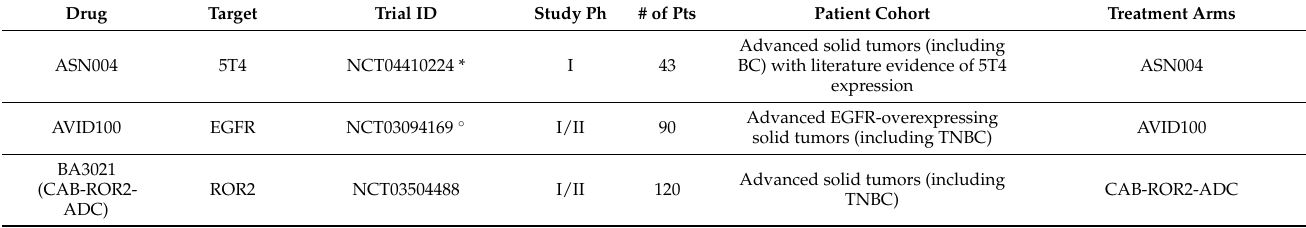
Table 2. Summary of the current clinical trials investigating antibody drug conjugates with targets other than HER2. Legend: ◦ Active, not recruiting; * Not yet recruiting. Abbreviations: ID, identifier; pts, patients; BC, breast cancer; EGFR, epidermal growth factor receptor; mTNBC, metastatic triple negative breast cancer; mBC, metastatic breast cancer; HER2, human epidermal growth factor receptor 2; CT, chemotherapy; ET, endocrine therapy; HR, hormone receptor; TPC, treatment of physician’s choice; eBC, early breast cancer; FRA, folate receptor alpha; HER3, human epidermal growth factor receptor-3; PD-L1, programmed death-ligand 1; 5T4, oncofetal antigen 5T4; ROR2, receptor tyrosine kinase-like orphan receptor 2; TROP-2, Trophoblast cell surface antigen 2; LIV-1, Zinc transporter ZIP6; FRA, Folate receptor alpha; ROR1, receptor tyrosine kinase-like orphan receptor 2; HER3, human epidermal growth factor receptor 3; BRCA1, Breast Related Cancer Antigen 1; BRCA2, Breast Related Cancer Antigen 2; PALB2, Partner and localizer of BRCA2; RAD51C, RAD51 homolog C; RAD51D, RAD51 homolog D; CPS, Combined Positive Score. Source: ClinicalTrial.gov, accessed on 15 March